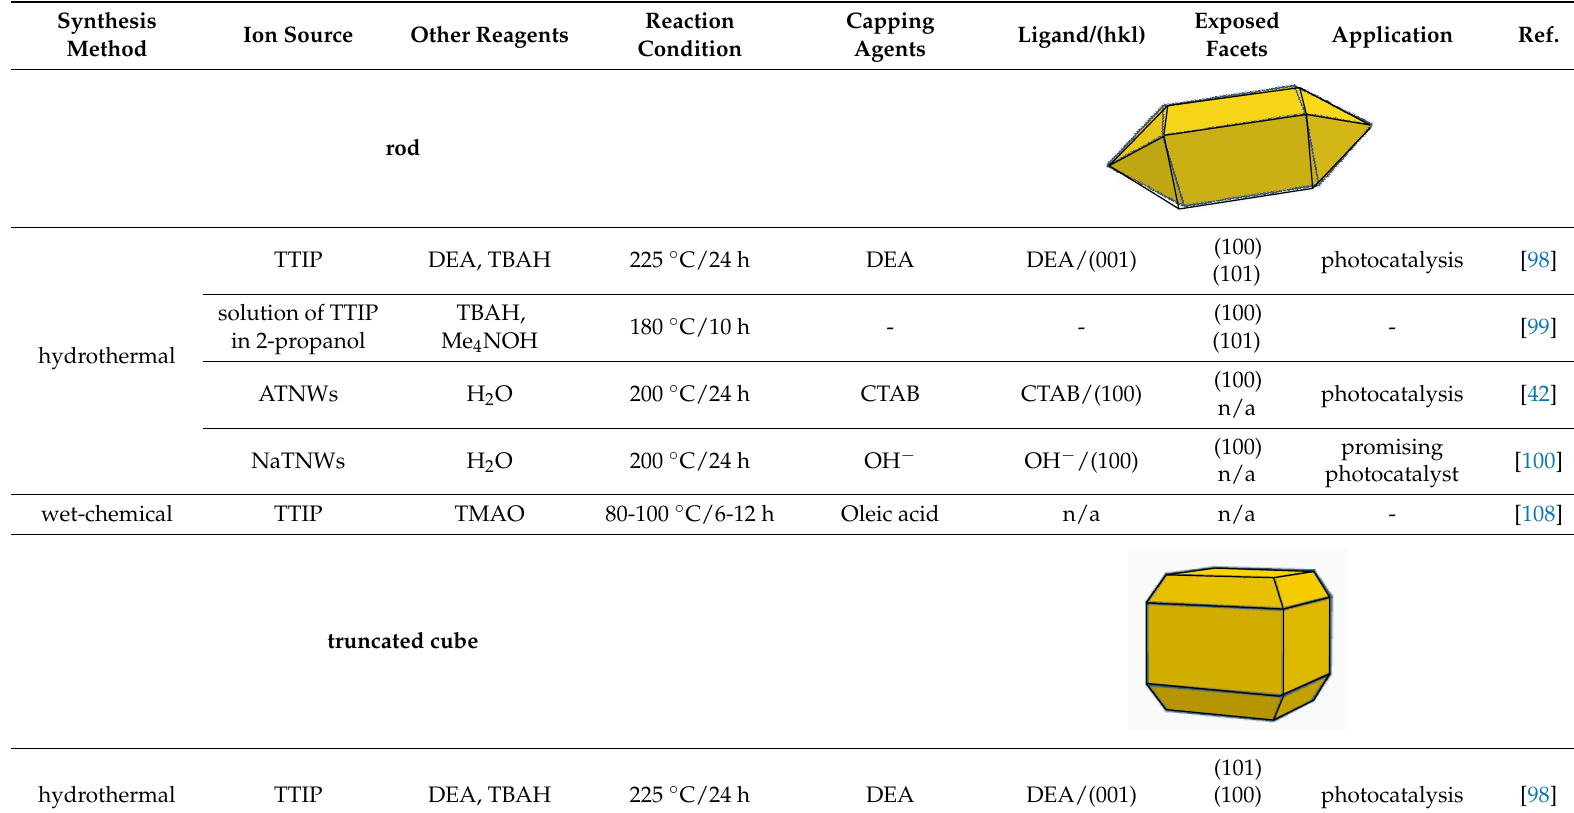
Table 3. Comparison of synthesis methods and application of various facet-dependent TiO 2.